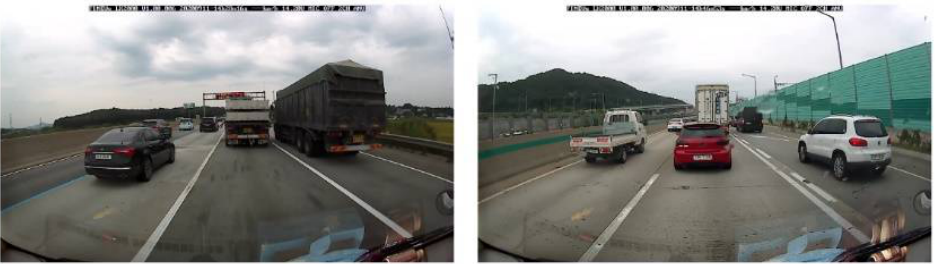
Figure 4. The example of Extracted Data.